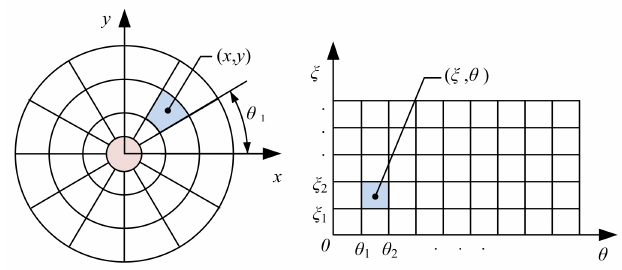
Figure 1. Mapping from Cartesian coordinates to log-polar